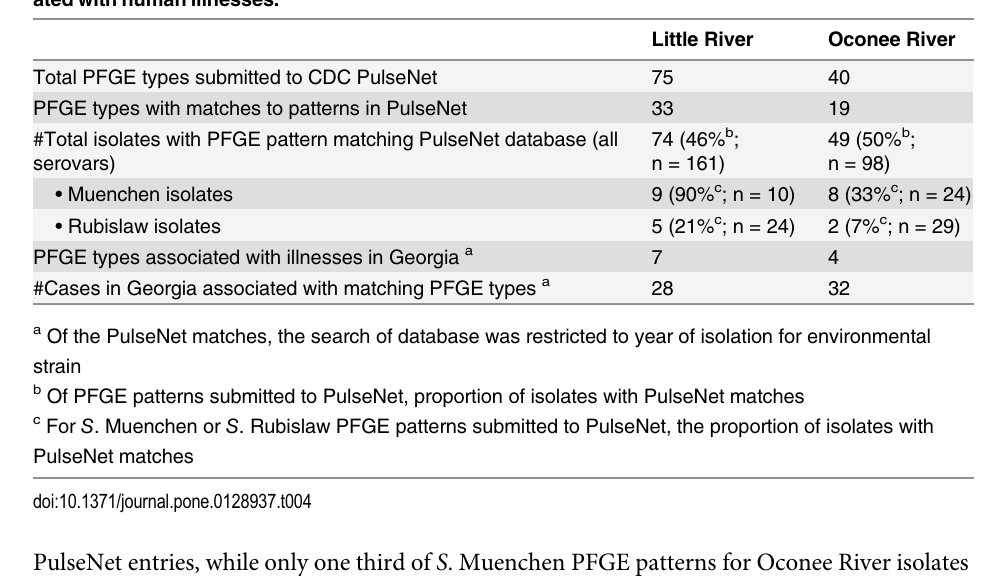
Table 4. Salmonella PFGE types isolated from the Little River and Oconee River watersheds associ- ated with human